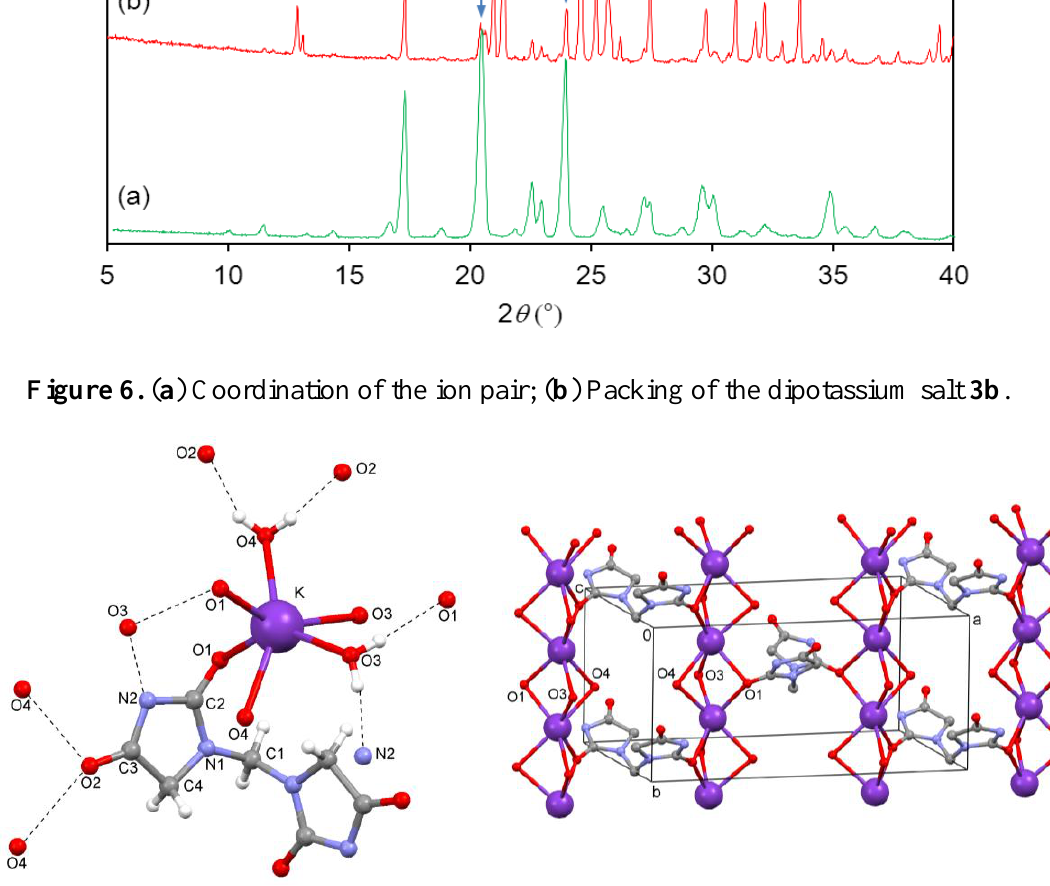
( a ) ( b ) Comparison of experimental and calculated PXRD data (Le Bail fit) of starting material 1 and dipotassium salt 3b are available in the Supporting Information (Figures S1 and